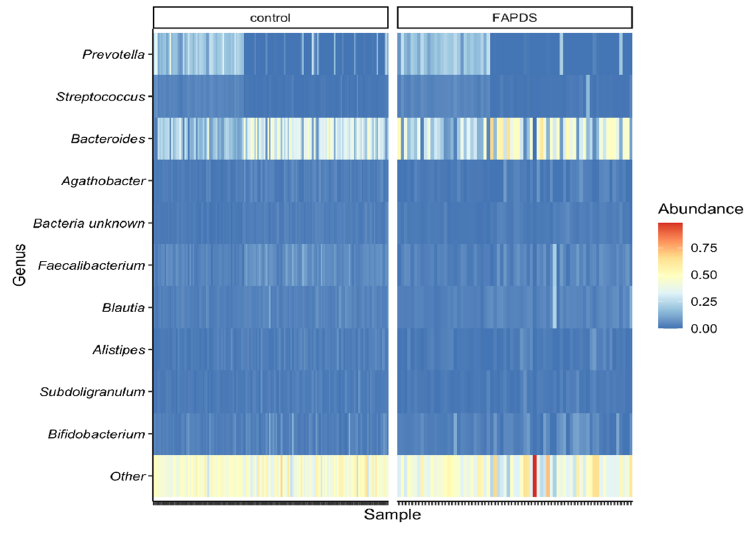
Figure 3. Heatmap illustrating the top ten identified bacterial taxa between the two groups.